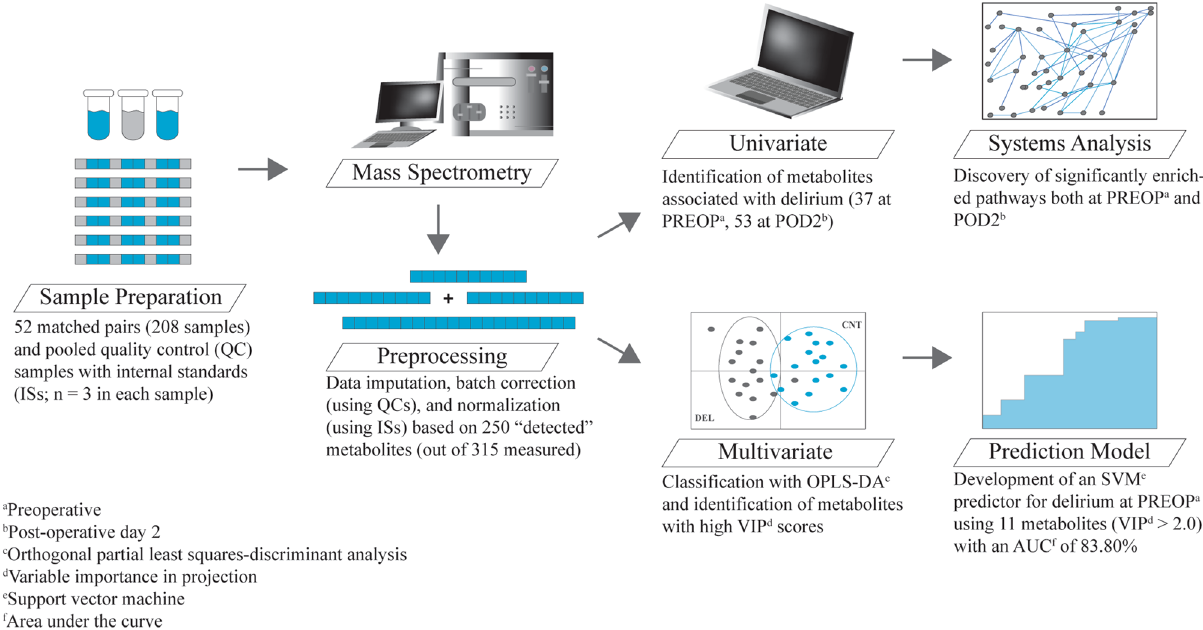
Figure 1. Experimental design workflow. Key steps in our experimental design included: sample preparation, mass spectrometric qualitative and quantitative analysis, data preprocessing, univariate and multivariate statistical analysis, systems analysis applied to the univariate findings, and predictive modeling using multivariate